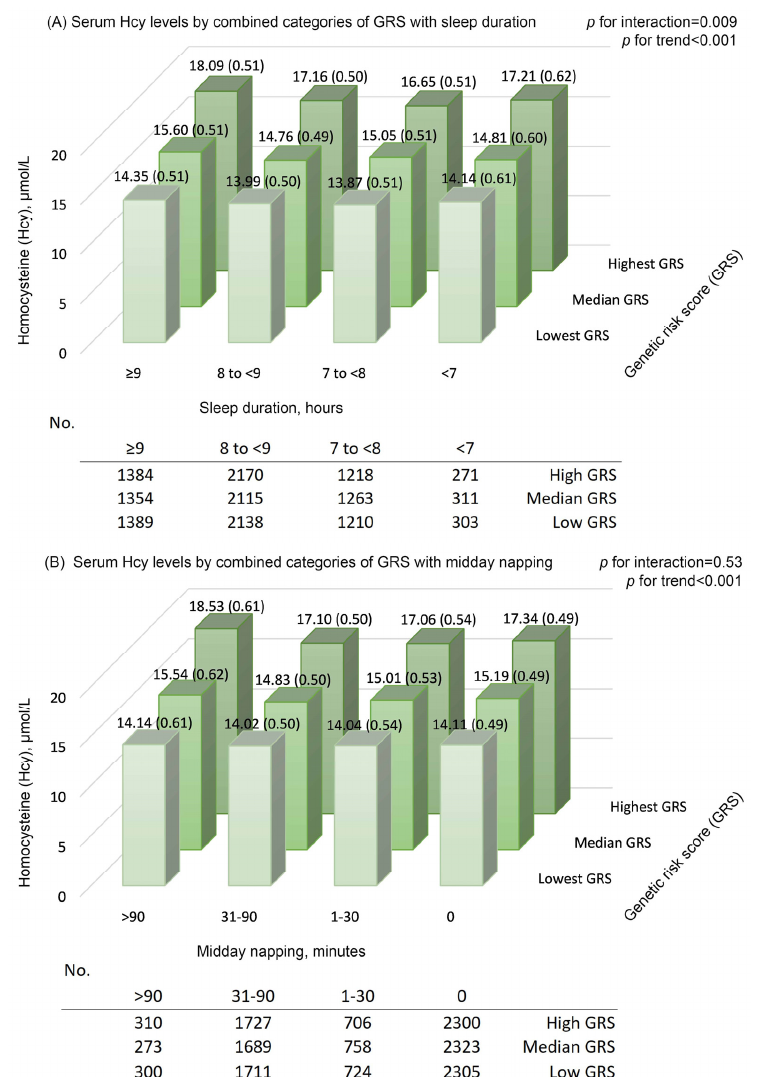
Figure 1. Serum homocysteine (Hcy) levels by combined categories of genetic risk score with ( A ) sleep duration and ( B ) midday napping. Means (standard error) were calculated with adjustments for age (continuous), sex (female, male), education level (primary school or below, middle school, high school or higher), body mass index (continuous), presence of hypertension, dyslipidemia, and diabetes (yes, no), smoking status (current, former, never), drinking status (current, former, never), dietary intake of meat, milk or dairy products, beans or soy products, fish or seafood, and fruits or vegetables ( ≥ 5 times/week; yes, no), regular exercise (yes, no), snoring (yes, no), and sleep quality (good, fair, poor); in addition, sleep duration (continuous) was adjusted for investigation of the GRS–napping interaction in Hcy, and midday napping (continuous) was adjusted for investigation of the GRS–sleep interaction in Hcy. The GRS (lowest, median, or highest group) groups were defined by tertiles for the total population. p for interactions was calculated by including the product term of GRS with sleep duration or midday napping in the multivariable-adjusted model, separately. GRS, genetic risk score; Hcy,